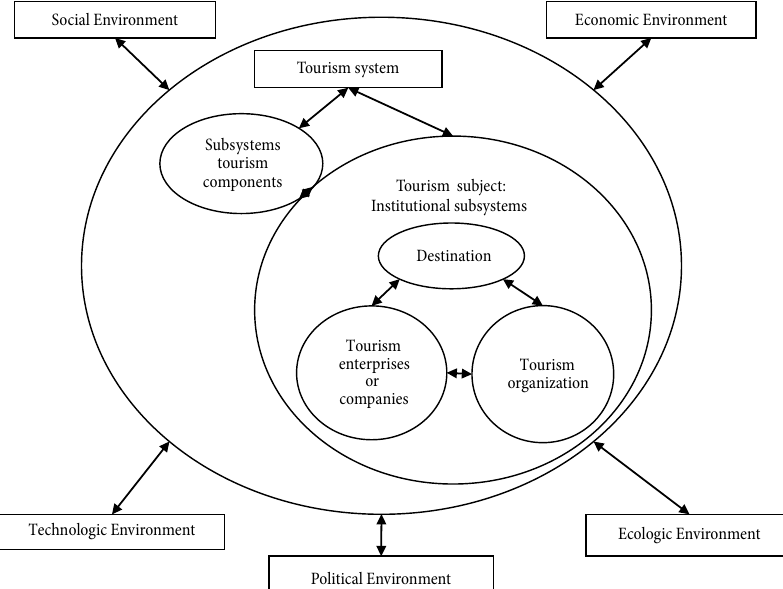
Fig. 1. Kaspar (1989) tourism